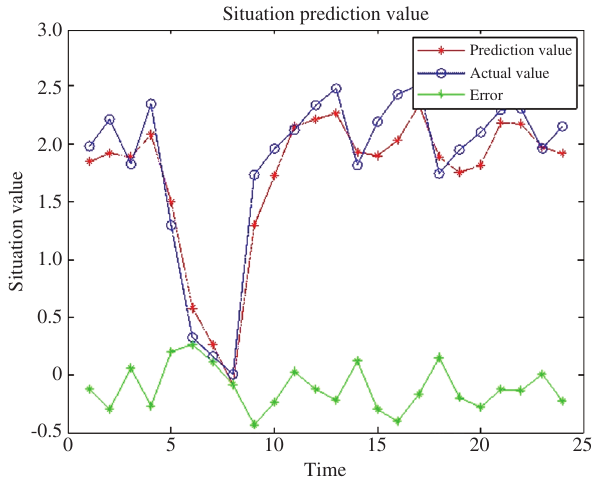
Figure 10. Prediction of the BP Neural Network.